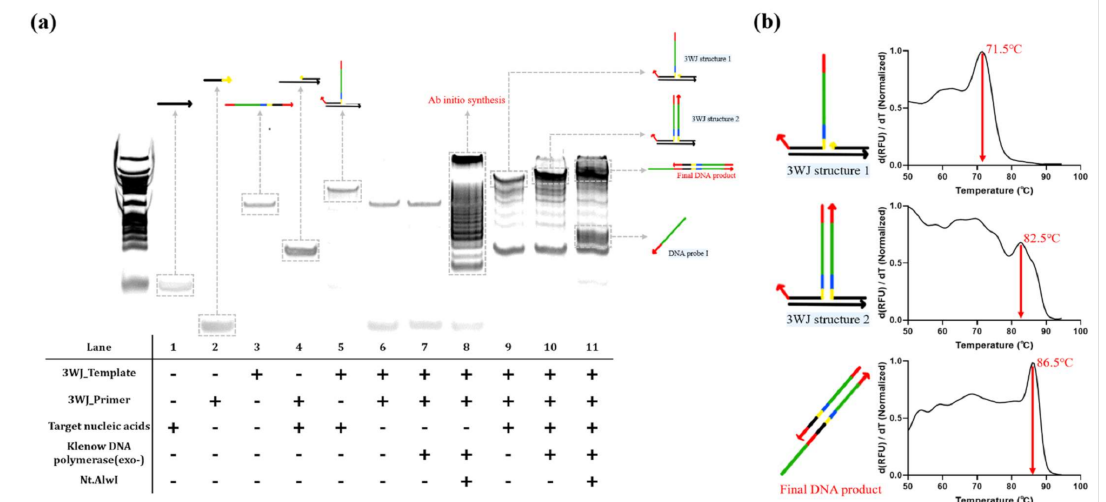
Figure 3. Confirmation of 3WJ-induced isothermal amplification. ( a ) Representative images of polyacrylamide gel elec- trophoresis of the reaction products obtained after strand displacement amplification. ( b ) Melting curve analysis for the reaction products obtained after strand displacement amplification. 3WJ structure 1: target DNA + 3WJ_template + 3WJ_primer (lane 9 in ( a )); 3WJ structure 2: target DNA + 3WJ_template + 3WJ_primer + Klenow DNA polymerase (exo-) (lane 10 in ( a )); final DNA product: target DNA + 3WJ_template + 3WJ_primer + Klenow DNA polymerase (exo-) + Nt.AlwI (lane 11 in ( a